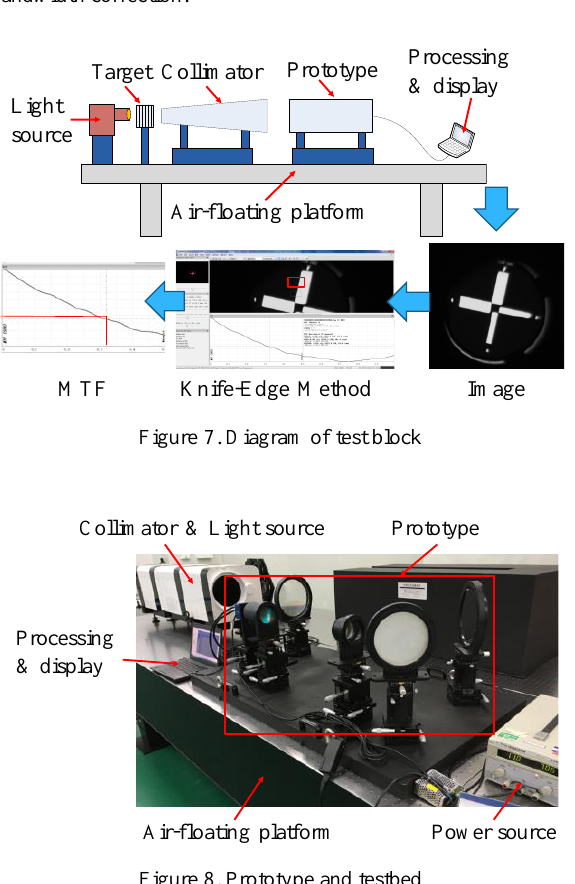
Figure 8. Prototype and testbed